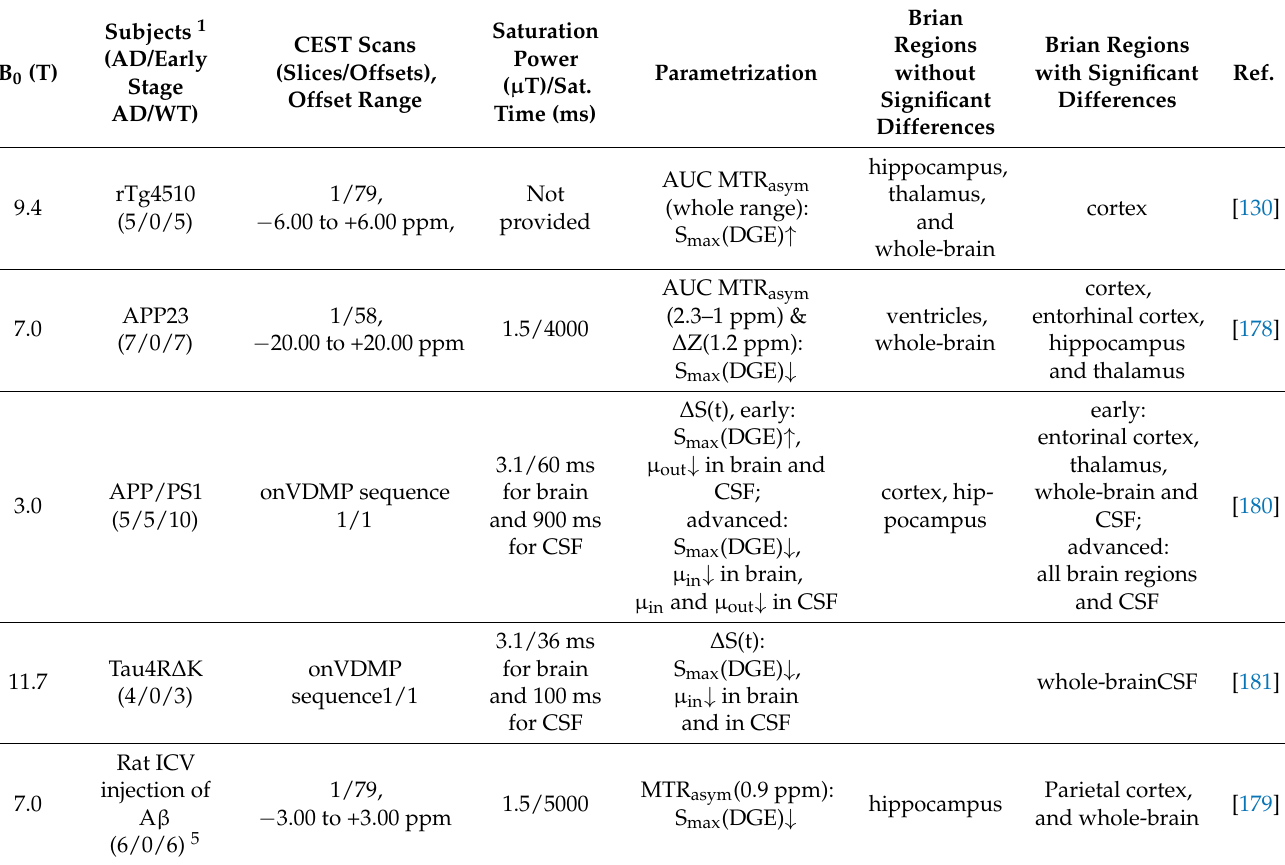
Table 6. Technical details of animal studies performed with the use of